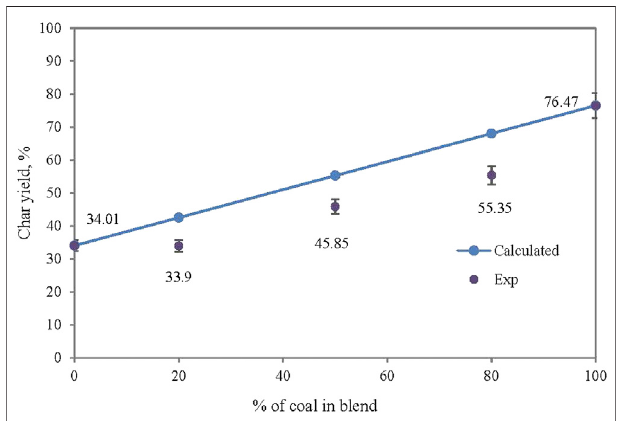
FIGURE 5 | Char yield from pyrolysis of coal/biomass blend at of 10 ° C/min.